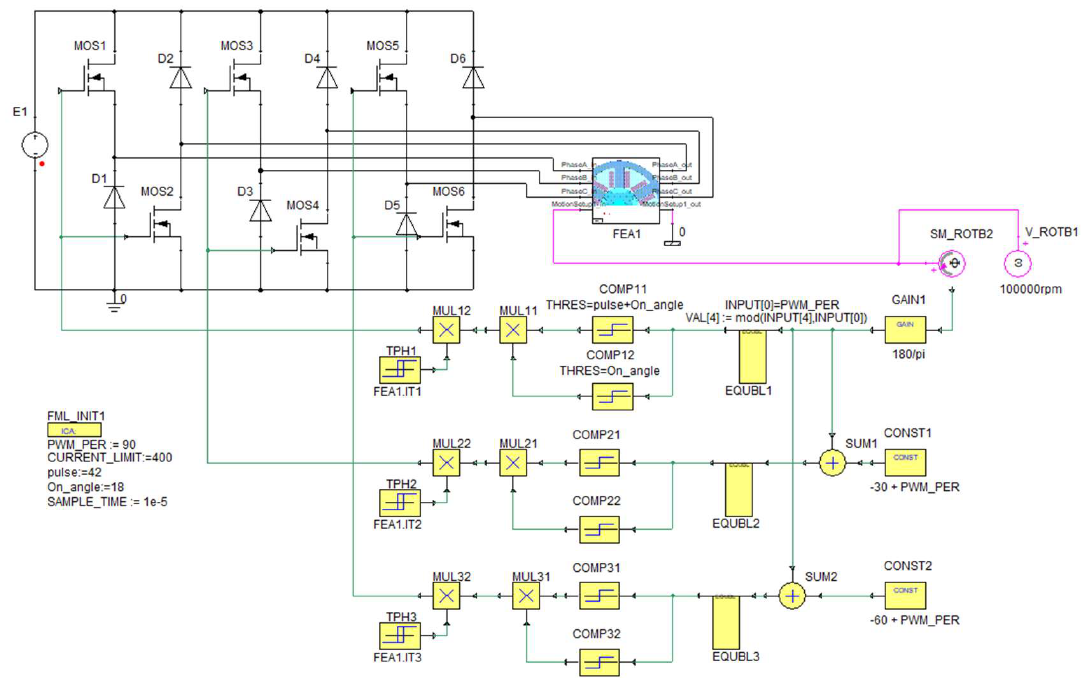
Figure 3. Supply circuit from Ansys—Twin Builder. Description of individual symbols: E—voltage source; D—diode; MOS—MOSFET transistor; FEA—FEM model of motor; SM_ROTB—rotational angle meter; V_ROTB—rotational angular velocity source; GAIN—proportional gain; EQUBL—equation block; CONST—constant value; COMP—comparator; MUL—multiplier; TPH—signal processing block—two-point element with hysteresis.